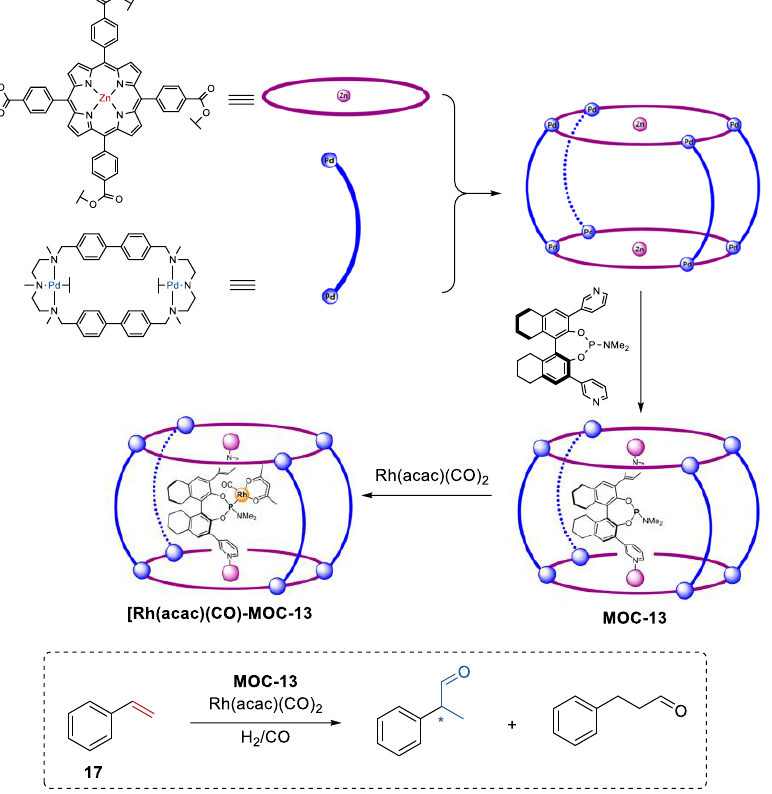
Figure 13. Regio- and enantioselective hydroformylation of styrenes catalyzed by the encapsulated chiral Rh catalyst in MOC-13 [79]. Reaction additions: 17 (8.3 × 10 − 2 mmol), MOC-13 (10 mol%), [Rh(acac)(CO) 2 ] (0.019 mol%), CH 3 CN/Toluene, H 2 /CO (1:1, 10 bar), r.t. Reprinted/adapted with permission from Ref. [79]. Copyright 2015 American Chemical Society. “ * ” in the figure indicates the chirality of the carbon.